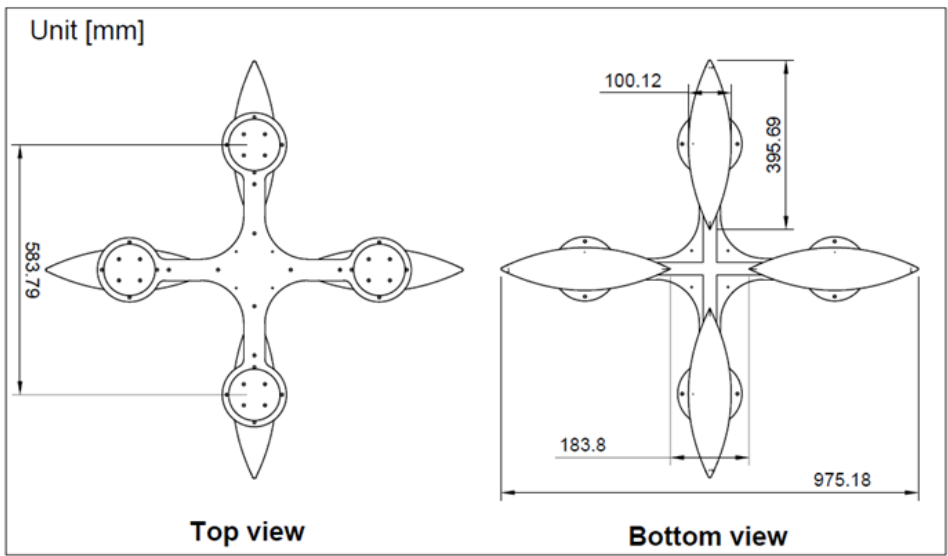
Figure 5. Principal dimensions of the 1/3 scale model.